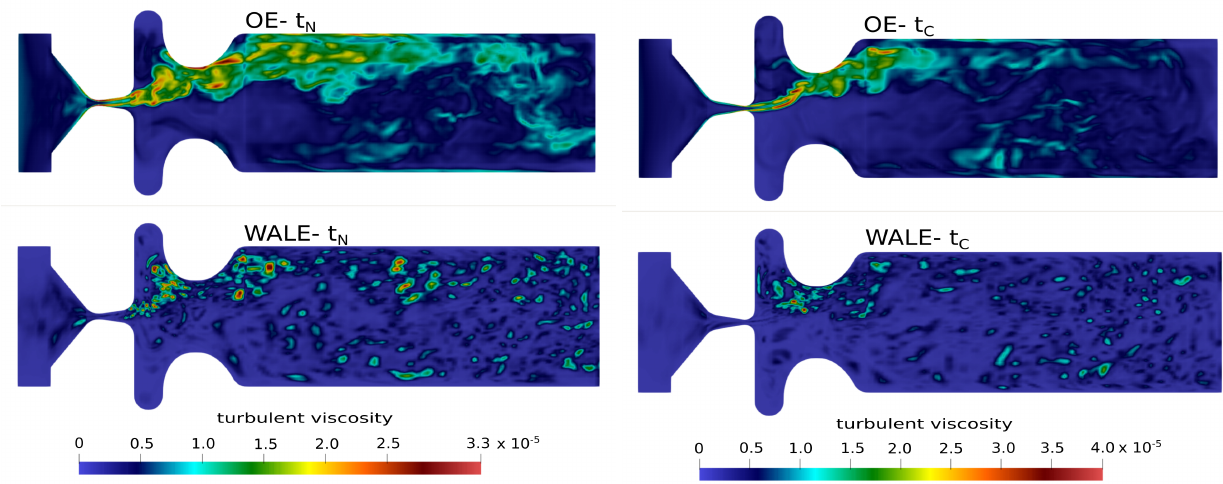
1.58 · 10 − 5 m 2 s − 1 . In contrast to this, the WALE SGS model predicts considerably lower values, not localized in the shear